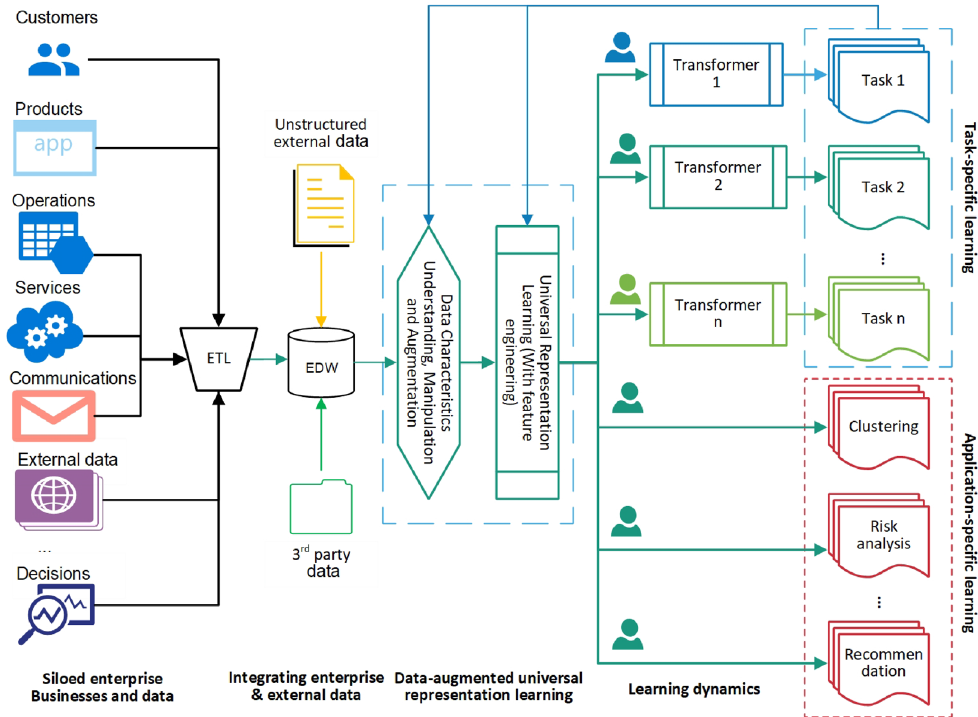
Figure 3. Automated universal representation-based enterprise data science for general-purpose and specific tasks in an enterprise. Data-augmented universal representations are learned on integrated enterprise data and enhanced to address business and data characteristics and dynamics, which can then be used for enterprise-wide and domain-specific learning tasks or applications in the